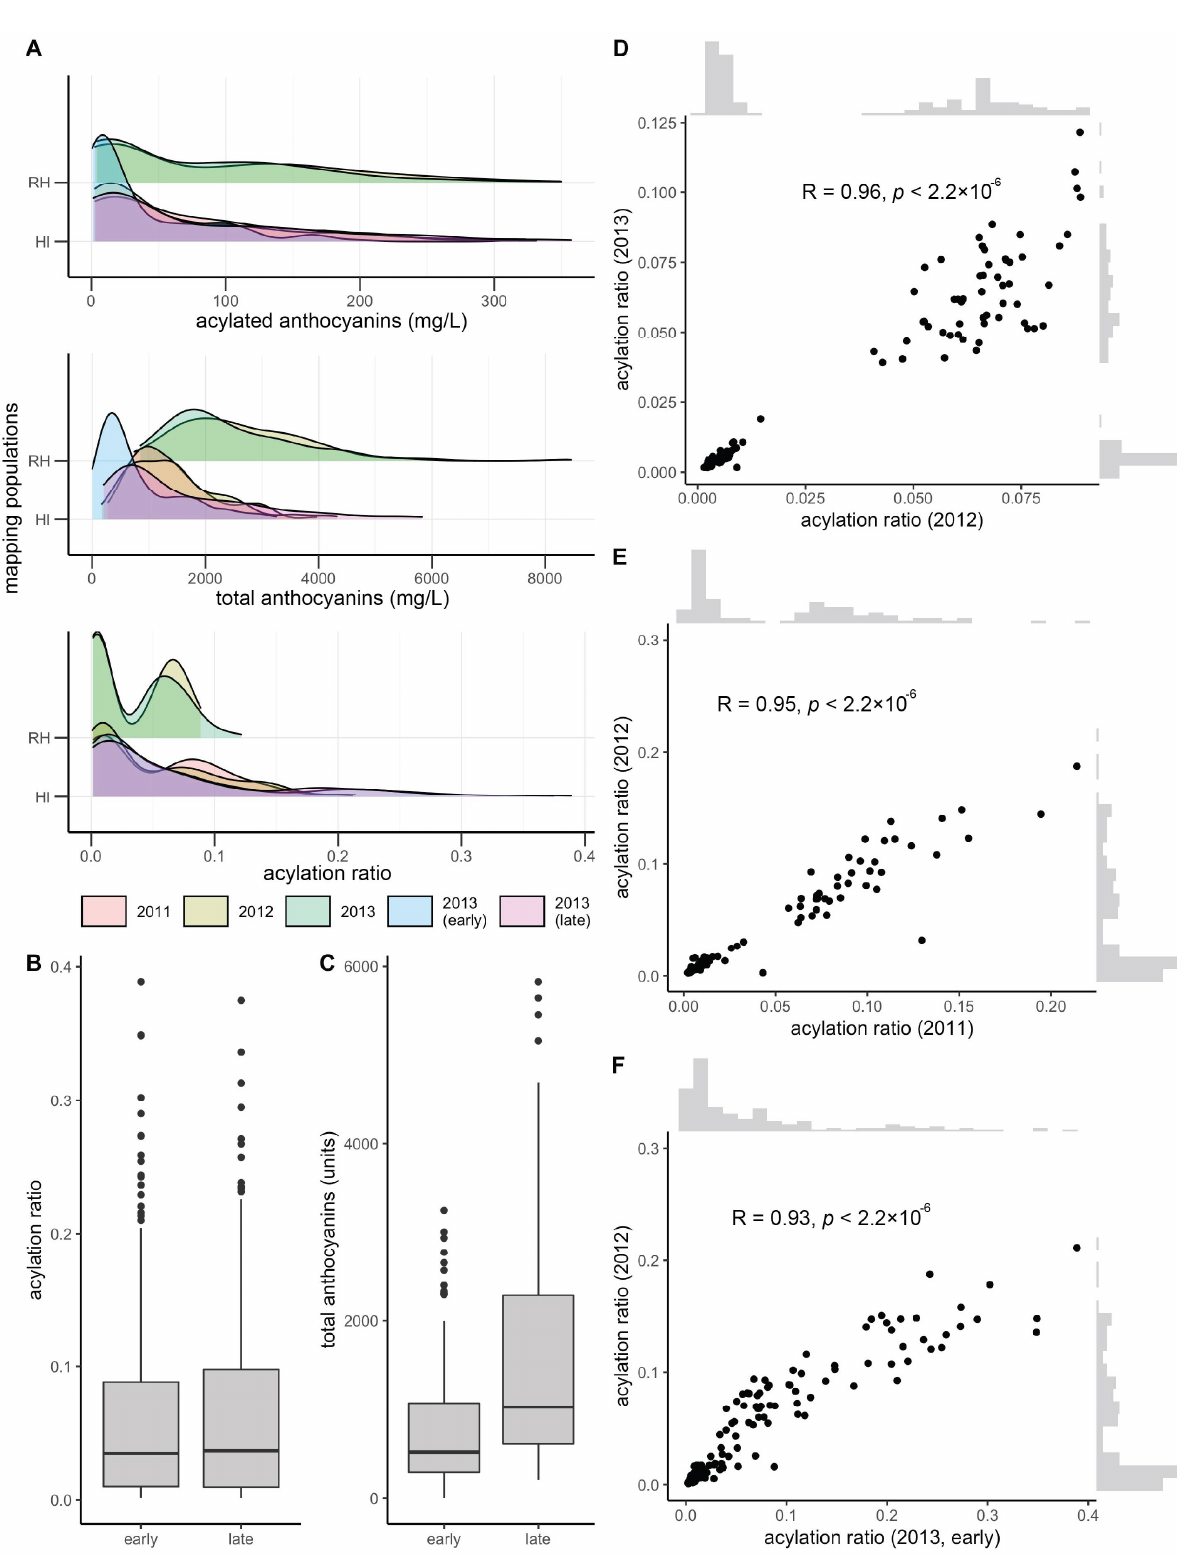
Figure 1. Overview of phenotypic variation. ( A ) Phenotypic variation observed for total anthocyanins, acylated antho- cyanins, and acylated ratio (acylated anthocyanins/total anthocyanins). Variation in ( B ) acylation ratio and ( C ) total anthocyanins by harvest time (early vs. late) during 2013 for ‘Horizon’ × Illinois 547-1. Year-to-year Pearson’s correlation for ( D ) V. rupestris B38 × ‘Horizon’ and ( E , F ) ‘Horizon’ × Illinois 547-1 acylation